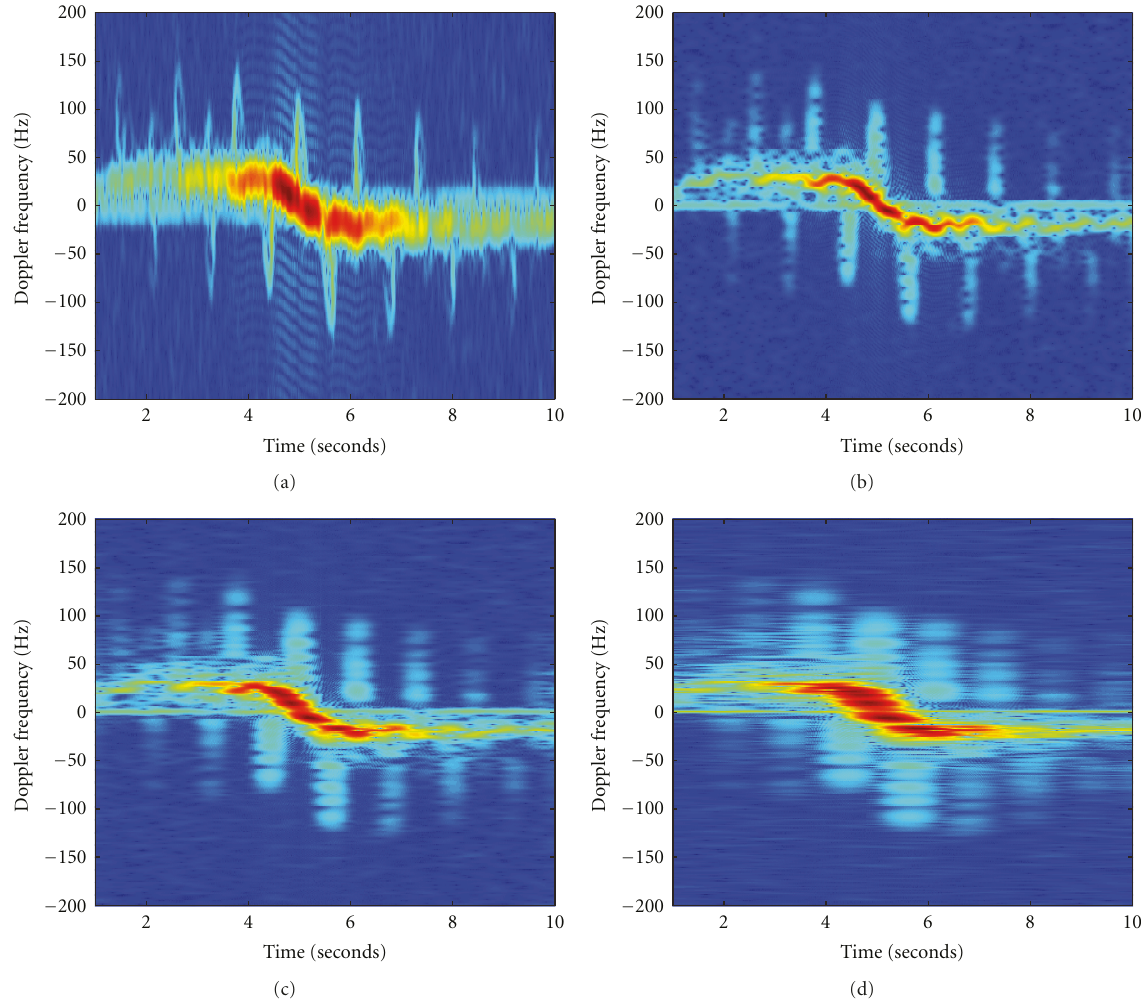
Figure 8: Spectrograms obtained using di ff erent Hamming window lengths: (a) 64 msec, (b) 256 msec, (c) 512 msec, and (d) 960 msec.